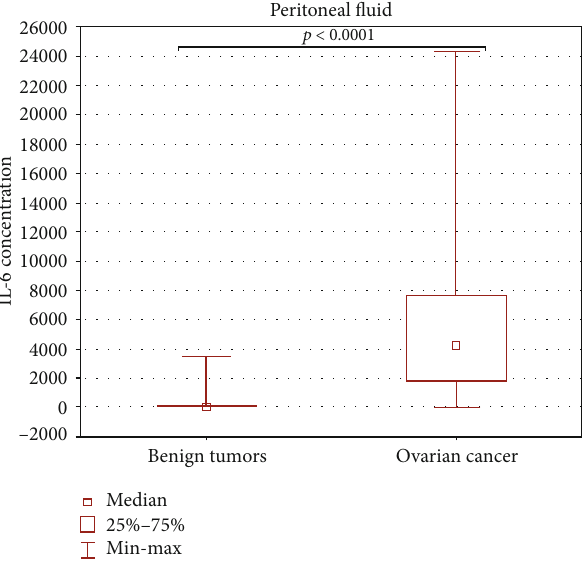
Figure 3: Levels of IL-6 (pg/ml) in the peritoneal fl uid of patients with ovarian cancer and in the group with benign ovarian